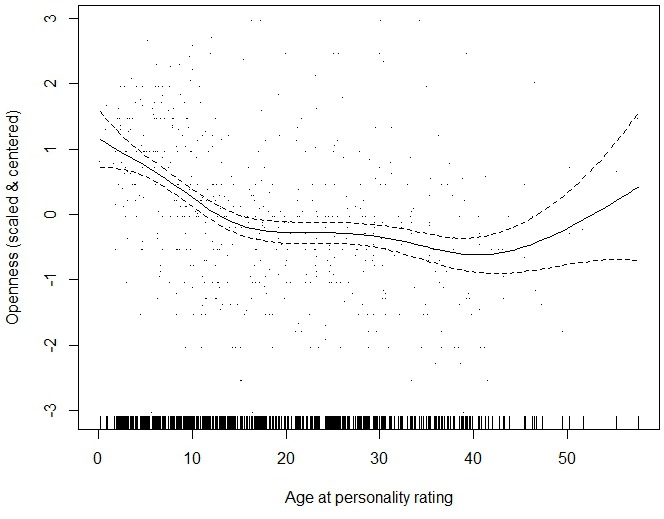
Generalized additive model of openness and age at personality rating.The carpet and scatter plot present the distribution of observations over which the best fit smoothed regression line is plotted with the 95% confidence region.